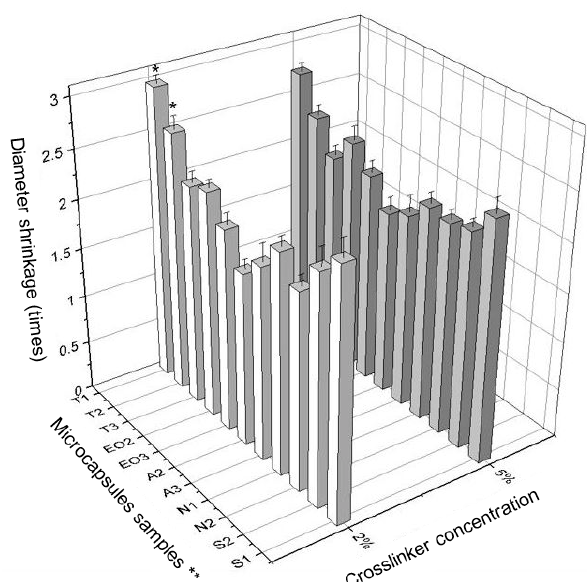
Figure 8. The difference in size (diameter shrinkage) between wet and dry microcapsules. * p < 0.05 vs. diameter of NEO-loaded microcapsules prepared in 5% crosslinker solution. ** The code is given in Table 1.